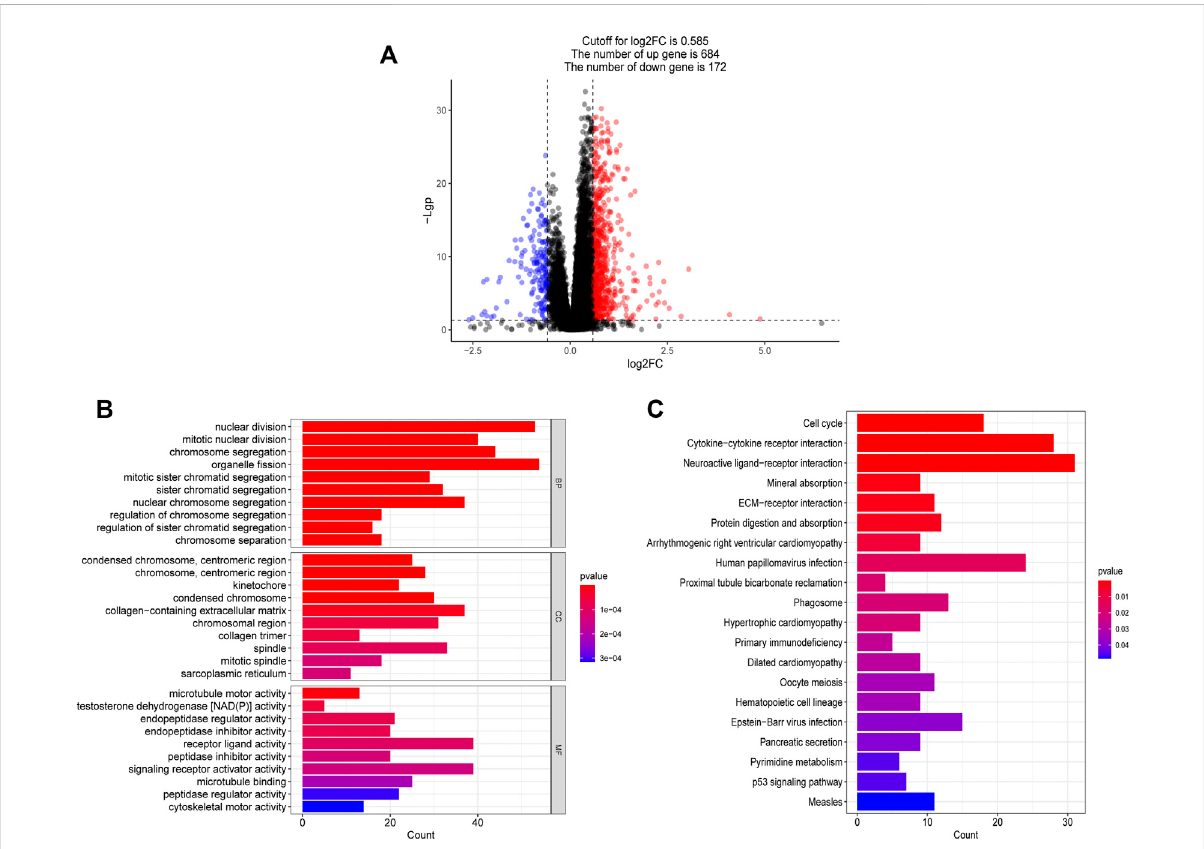
FIGURE 10 Functional analysis based on the DEGs between high and low risk groups. (A) The differentially expressed genes between high and low risk groups. (B) ThebargraphofGOenrichmentanalysis,BP(biologicalprocess),CC(cellularcomponent),MF(molecularfunction). (C) The bargraphof KEGG enrichment